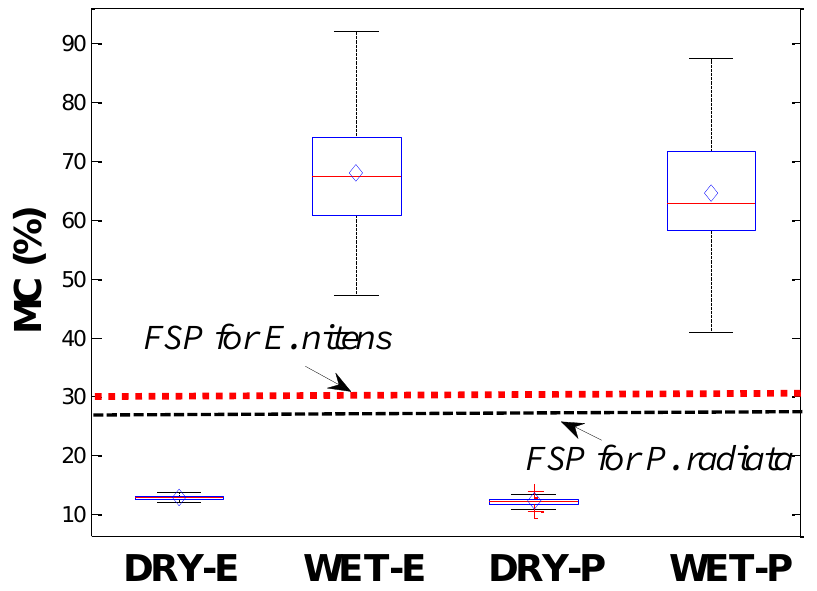
Figure 4. Boxplot of MC for E. nitens samples compared with the corresponding P. radiata samples. Both the mean moisture contents of this research are far above the FSP . The Wood Handbook and previous studies have found that there are no fundamental changes in failure strength for an MC above the FSP [9,11,14]. Therefore, the 4.8% difference in MC does not significantly influence the values of the failure strengths studied. This indicates that the measured failure strengths from both P. radiata and E. nitens samples are